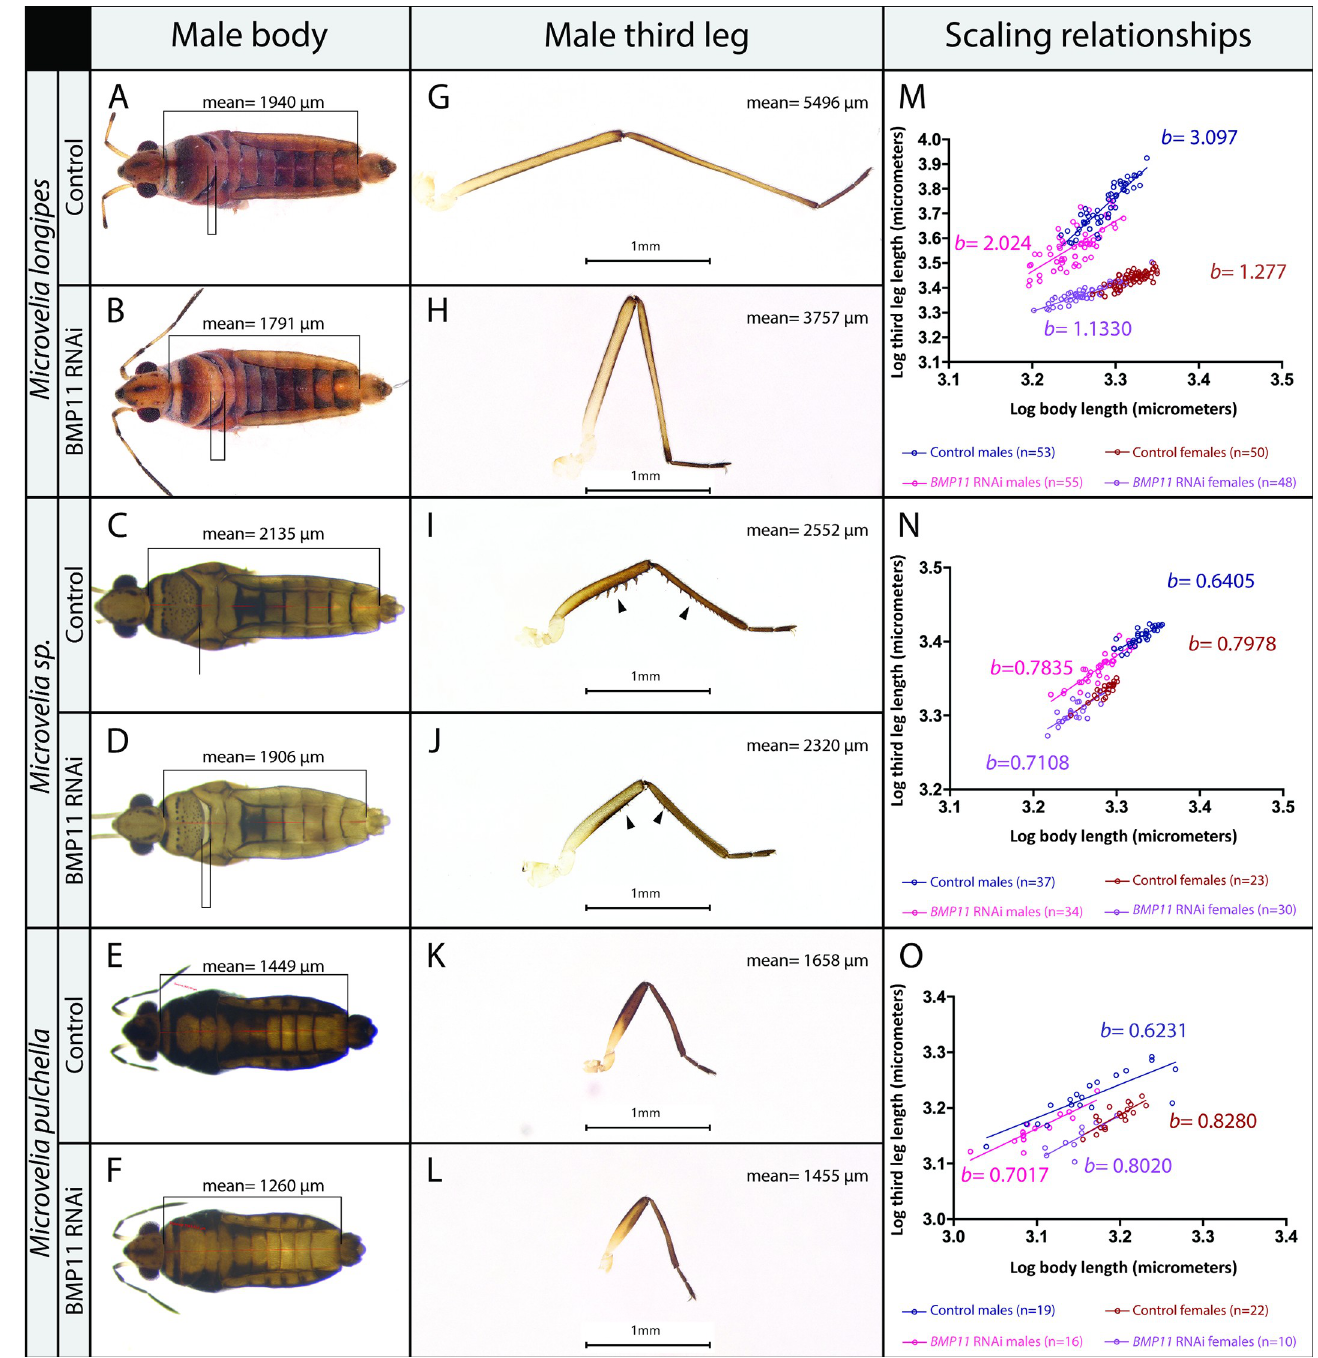
Fig 3. Effect of BMP11 RNAi on the growth and scaling relationships of various traits in 3 species of Microvelia . The pronotum in (A) M . longipes and (C) M . sp., but not in (E) M . pulchella , covers the entire mesonotum (brackets in A and C). BMP11 RNAi characteristically reduces the size of the pronotum in M . longipes and M . sp. (brackets in B and D). ( E, F ) This effect is absent in M . pulchella , consistent with the absence of this trait. ( G–L ) Only M . sp. males have a set of spines in the third legs (arrowheads in I), which are removed or reduced due to BMP11 RNAi (arrowheads in J). The lengths of the third legs are reduced in adult males and females. Statistical analyses can be found in S6 Table. M . pul stands for M . pulchella . (M–O) Effect of BMP11 RNAi on adult male and female scaling relationships between leg length and body length of M . longipes (M), M . sp. (N), and M . pulchella (O). Statistical analyses can be found in S6 Table. Comparisons of adult static allometries for each species between controls and BMP11 RNAi for males and females are shown in the keys below graphs. Linear regressions were fitted to the log-transformed datasets. Samples sizes for each species are indicated in the panels. Statistical analyses were also performed on log-transformed data and can be found in S6 Table. The data underlying this figure may be found in S6 and S7 Tables. BMP11, Bone Morphogenetic Protein 11; RNAi, RNA interference.